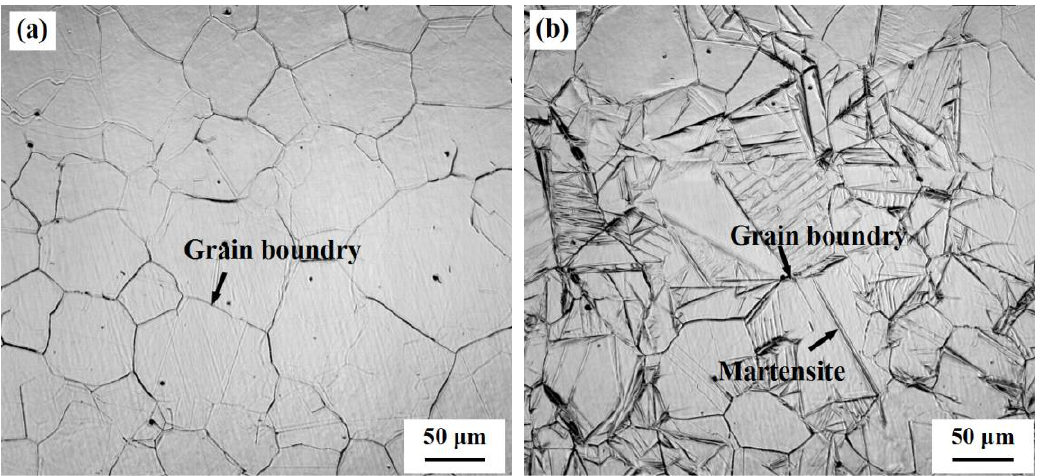
Figure 2. LSCM (laser scanning confocal microscope) images of the QBT specimen. ( a ) before and ( b ) after quenching.